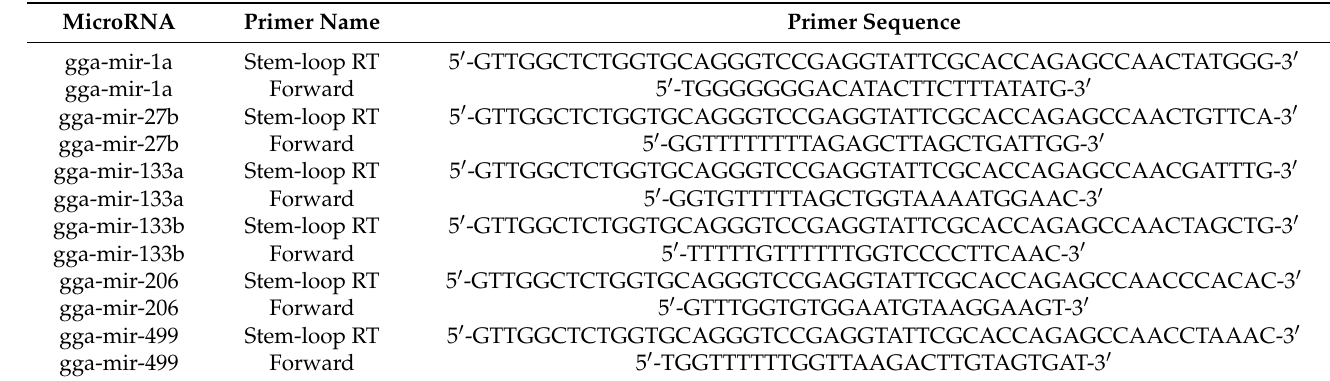
Table 3. The primer sequences for microRNA real-time reverse transcription